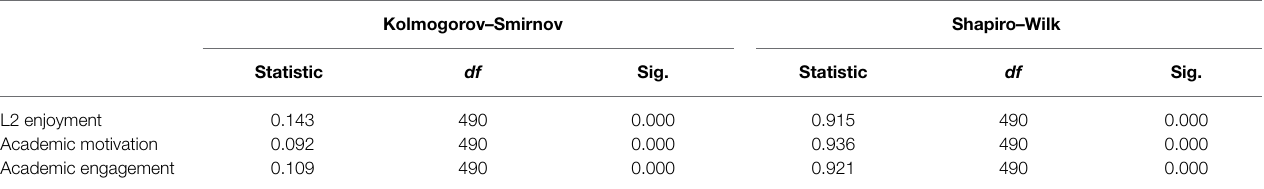
TABLE 2 | The associations between academic motivation, L2 enjoyment, and academic engagement.